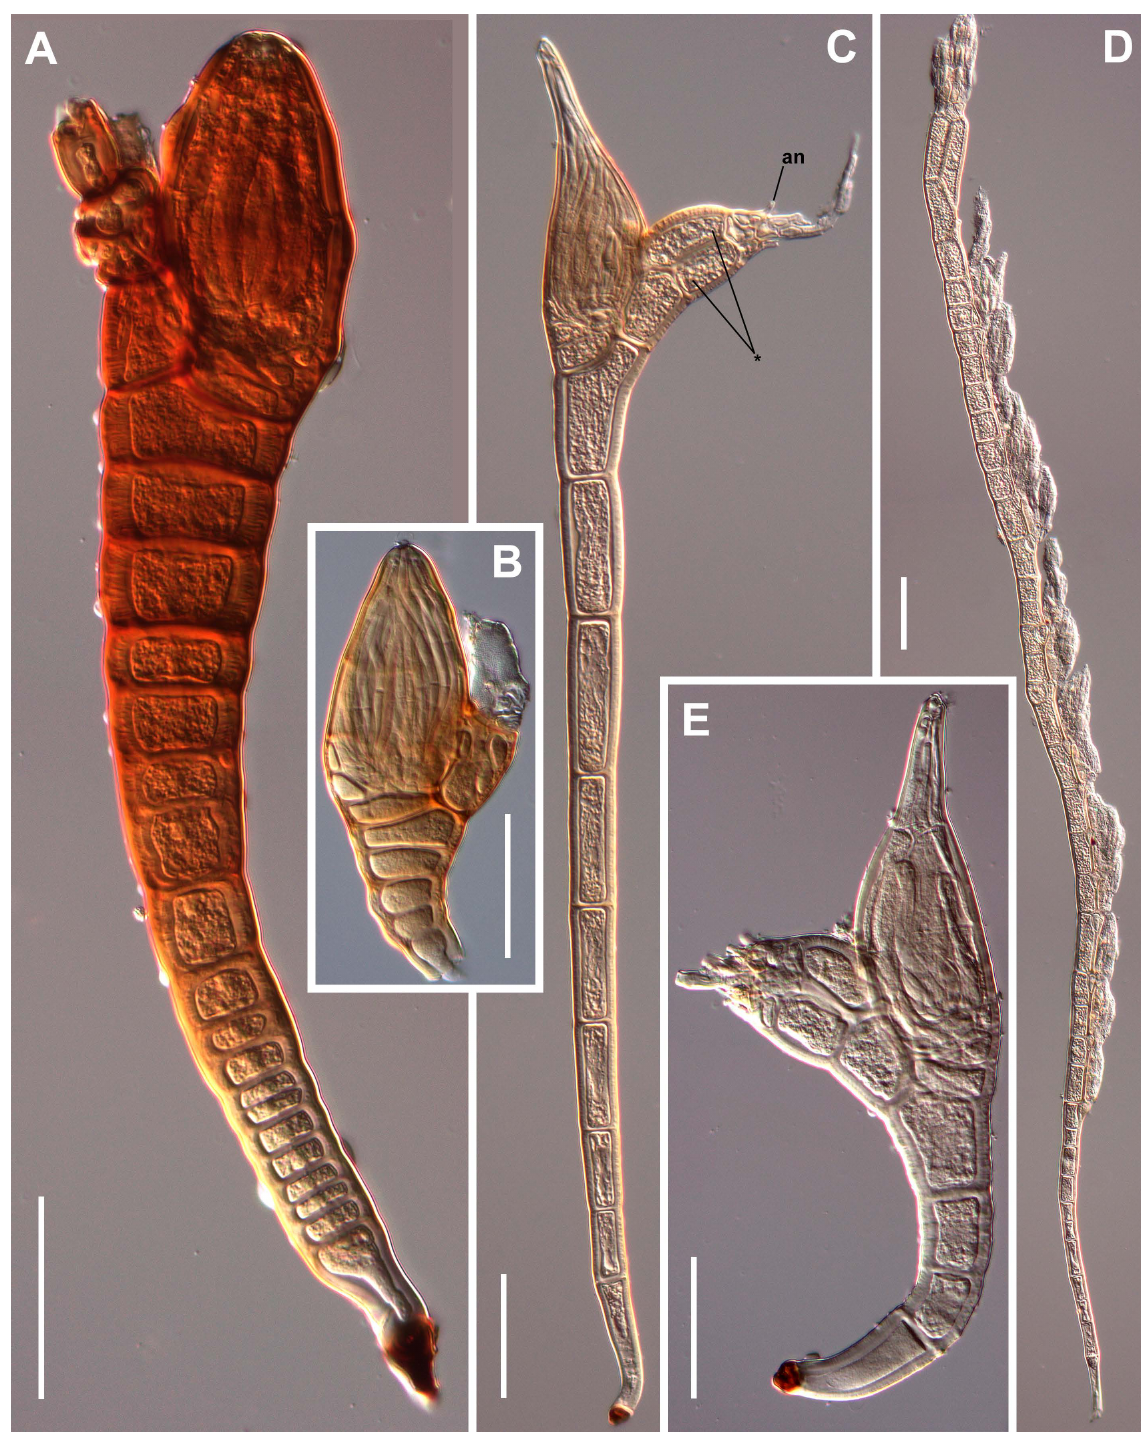
Fig. 23. A – B . Misgomyces dyschirii Thaxt. Mature thalli from pronotum (A) and tarsi (B). – C – E . Botriandromyces heteroceri (Maire) I.I.Tav. & T.Majewski. C . Mature thallus from elytra, showing two parallel cells of upper receptacle (*) and antheridia (an). D . Filiform thallus without perithecium, filled with clusters of antheridia on one side. E . Mature thallus from tarsi. Scale bars: 50 µm. Photographs from slides ZMUC C-F-122694 (A), ZMUC C-F-123644 (B), ZMUC C-F-122594 (C–D), ZMUC C-F- 122660